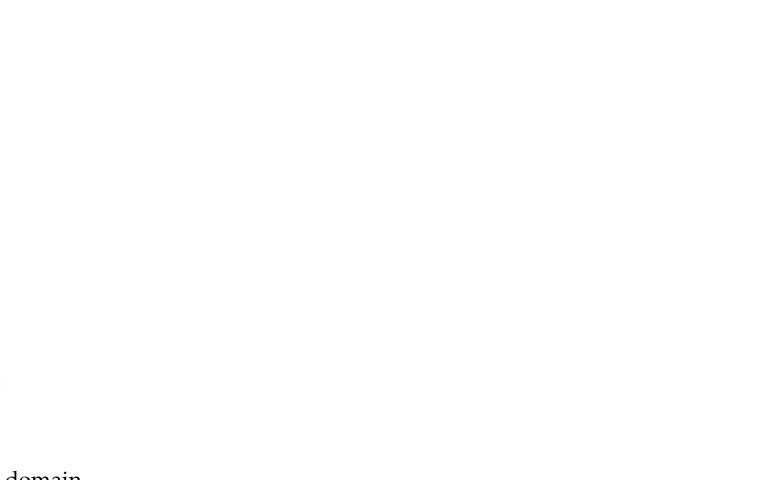
Figure 1. The modeling domain.